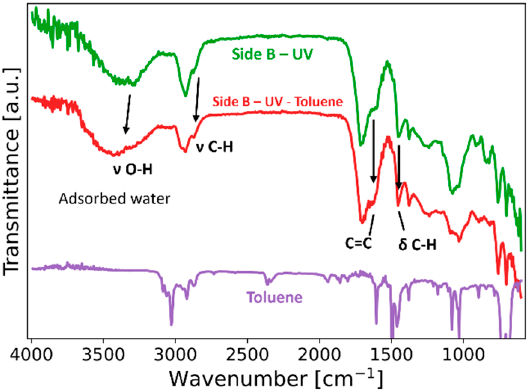
Figure 8. FTIR spectra of Side B after UV exposure and Side B after the toluene filtration experiment. The IR spectrum of toluene is also shown for reference.